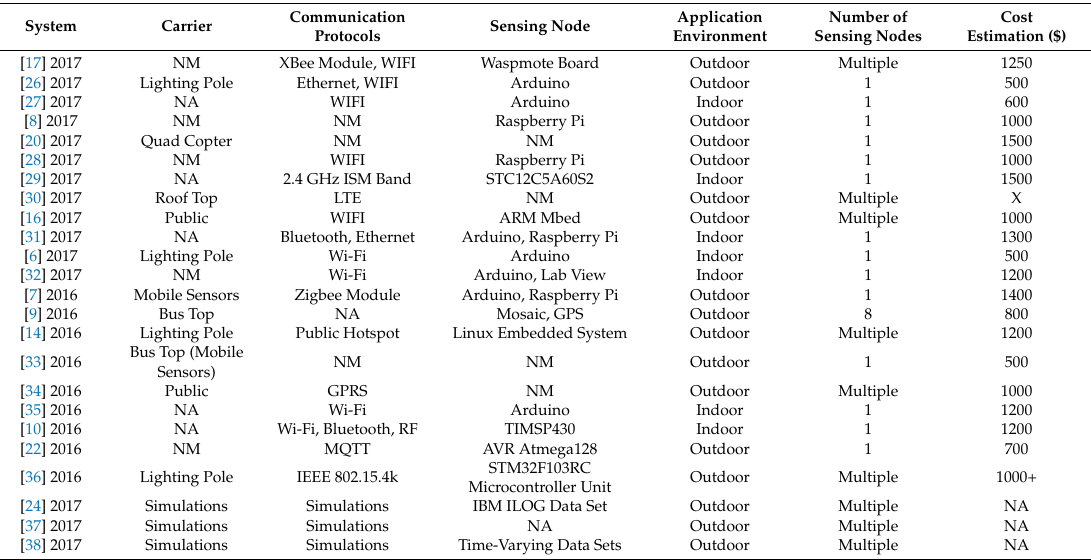
Table 2. Summary of the related